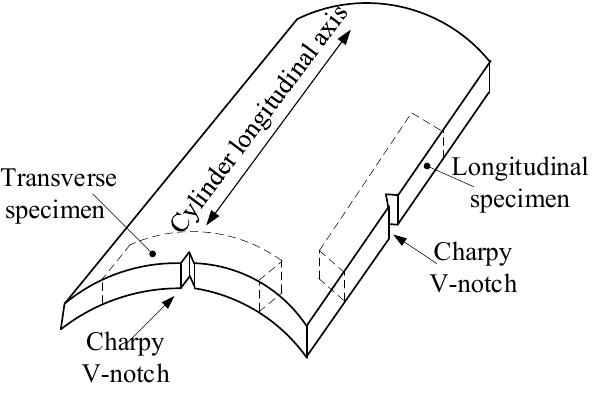
Figure 3. Specimens for impact test.